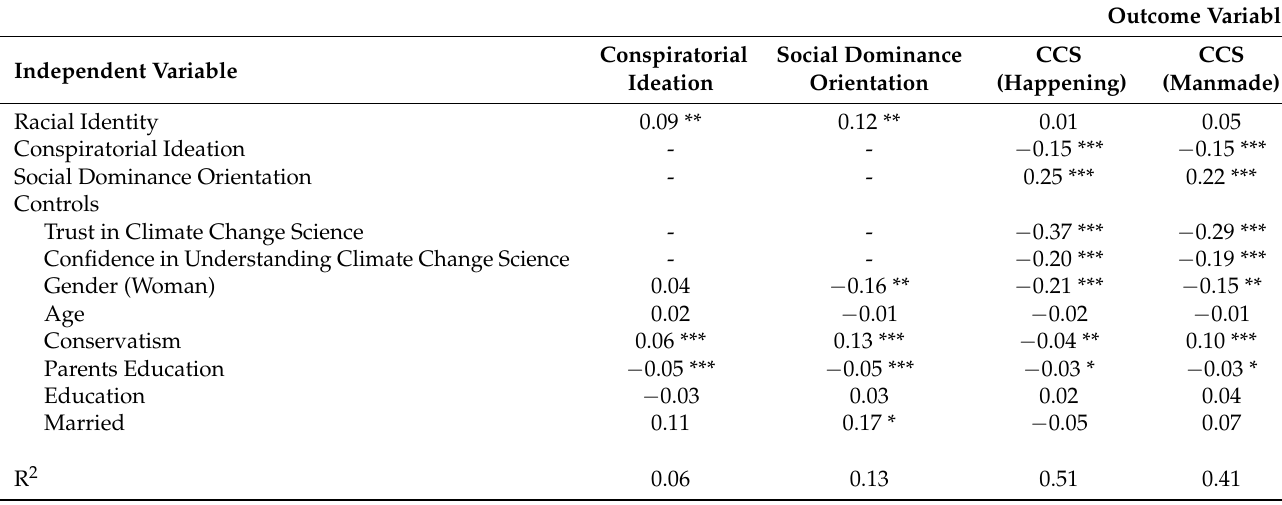
Table 2. Unstandardized Coefficients of Seemingly Unrelated Regression: Racial